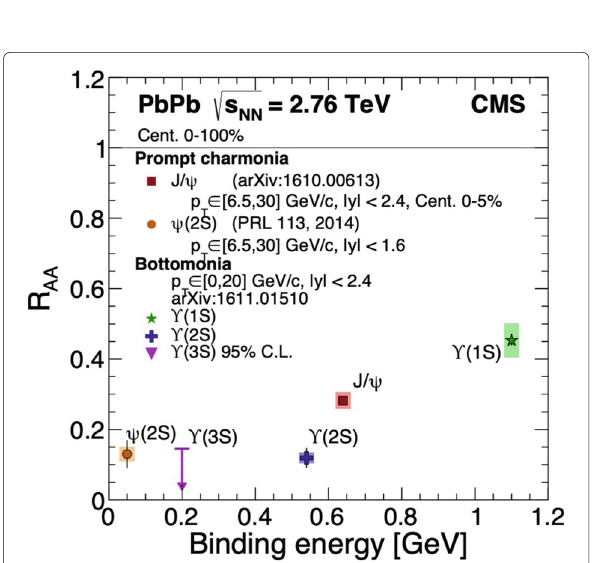
Fig. 11 R AA of quarkonium states as a function of the binding energy √ s NN = 2.76 TeV measured by the CMS in Pb+Pb collisions at experiment, which is consistent with the sequential suppression pattern